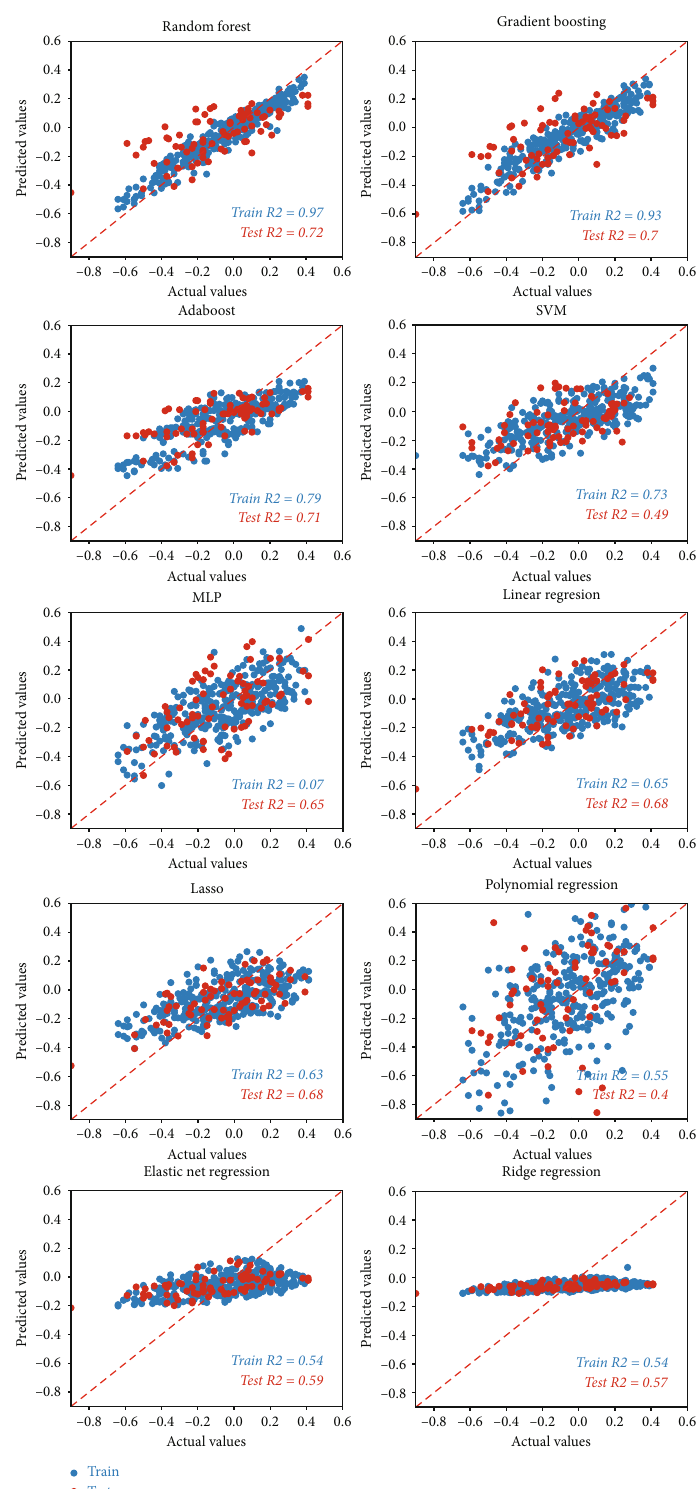
Figure 7: Crossplot between actual values and predicted